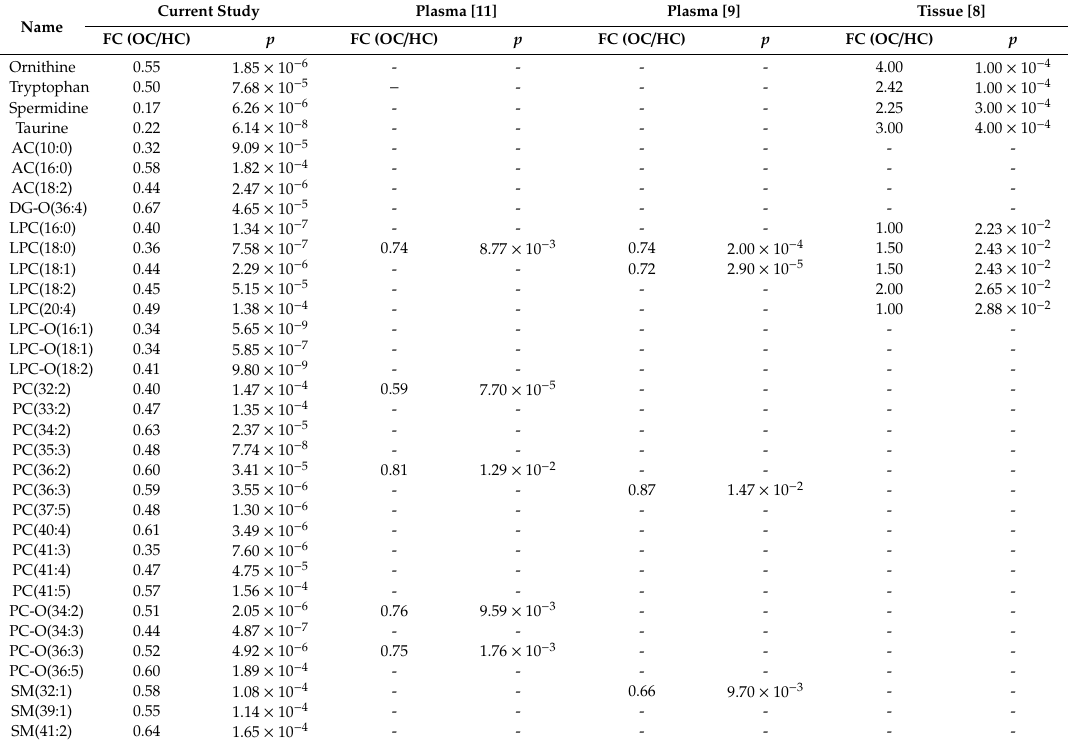
Table 2. Meta-analysis of DAMs with already published